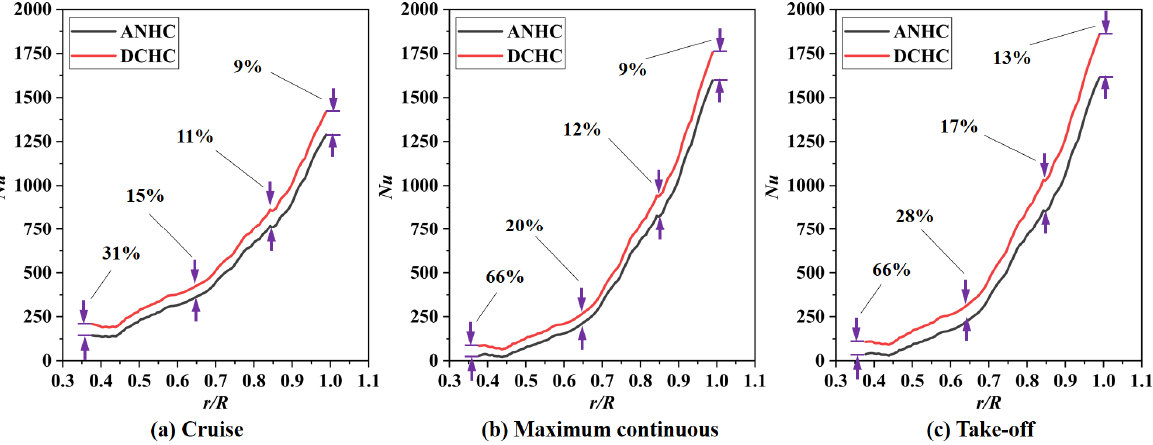
Figure 33. Nusselt number recovery from compensation design.